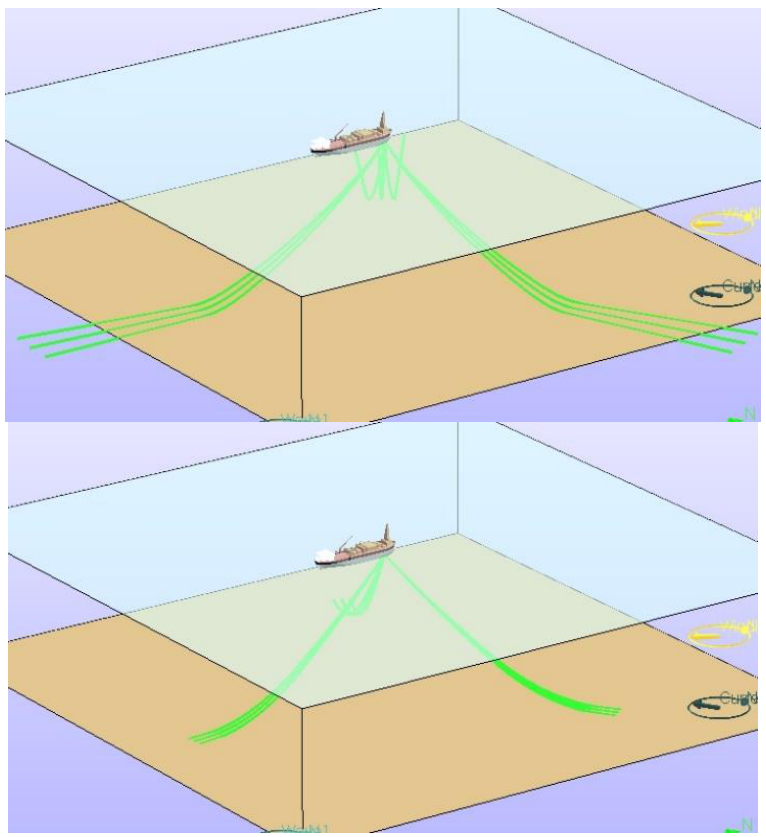
Figure 9. The initial ( top ) and optimized ( bottom ) mooring configuration for case C.